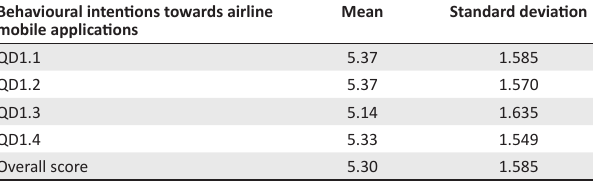
TABLE 3: Descriptive statistics for behavioural intentions towards airline mobile applications. Behavioural intentions towards airline mobile applications